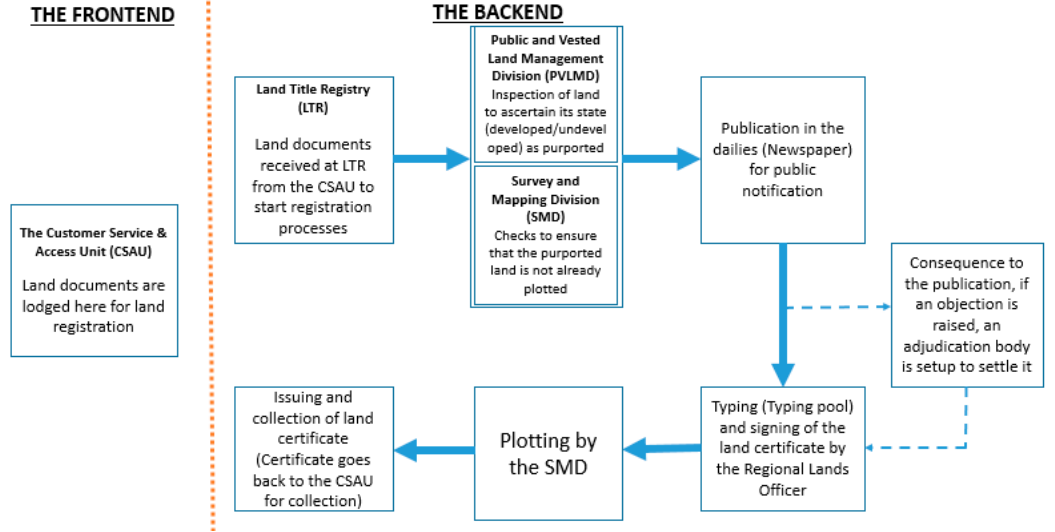
Figure 3. Land registration process. Based on [57,58].